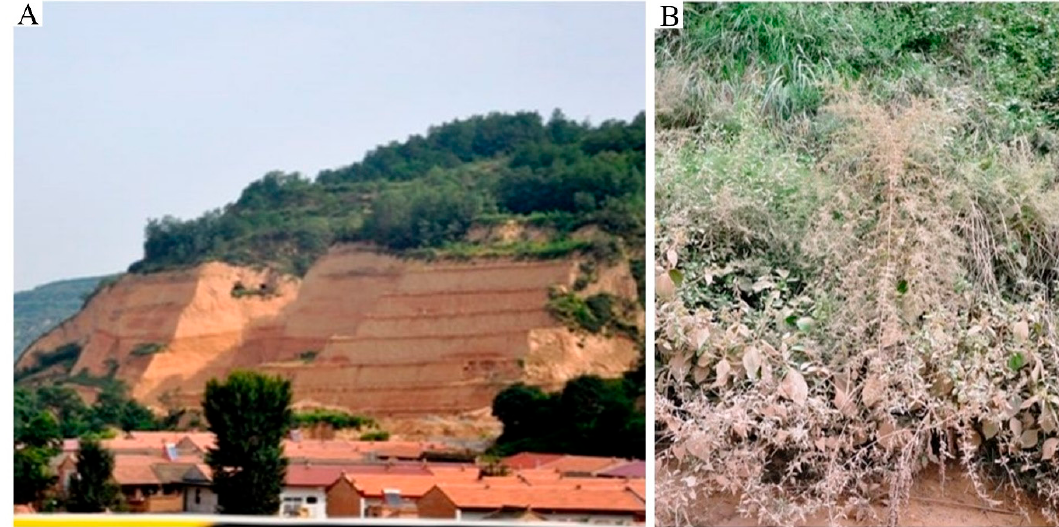
Figure 1. Disturbed loess surfaces present a main source of dust. Disturbed vegetation cover exposes a large surface of loess landscape which acts as a source of dust (Luochuan Xiefeng, China) ( A ) and consequently causes damage to the vegetation cover (Luochuan Xiefeng, China) ( B ).